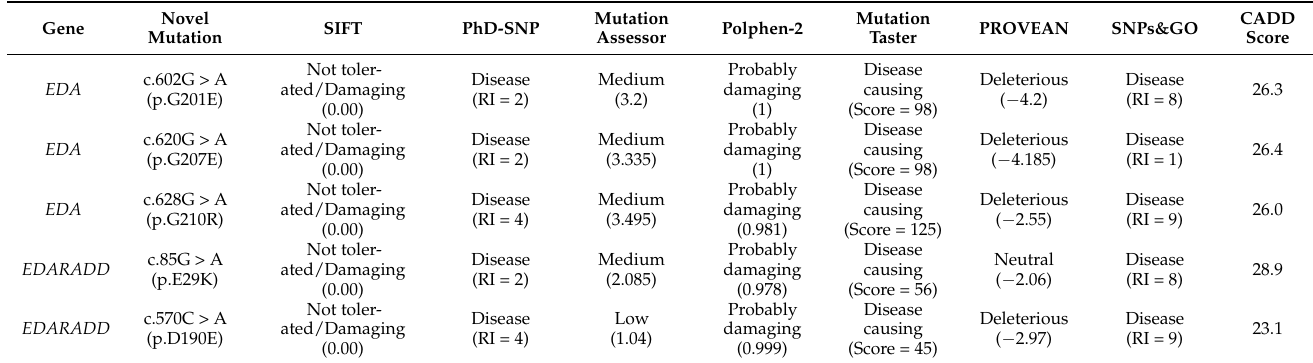
Table 4. In silico analysis of novel missense